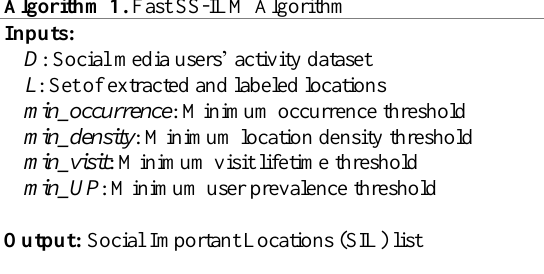
Algorithm 1. Fast SS-ILM Algorithm